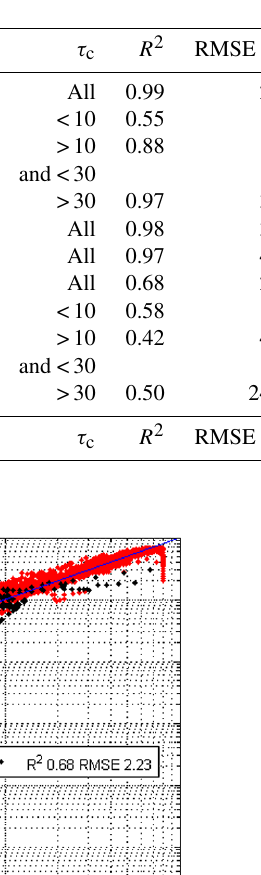
Table 2. Statistics of RRBR comparison against the Min et al. method in overcast skies (cloud fraction>0.7) and microwave radiometer (MWR) measurements. RMSE [–] is the absolute root mean square error, RMSE [%] is the relative root mean square error, MAE [%] is the relative mean average error, and MBE [%] is the relative mean bias error.